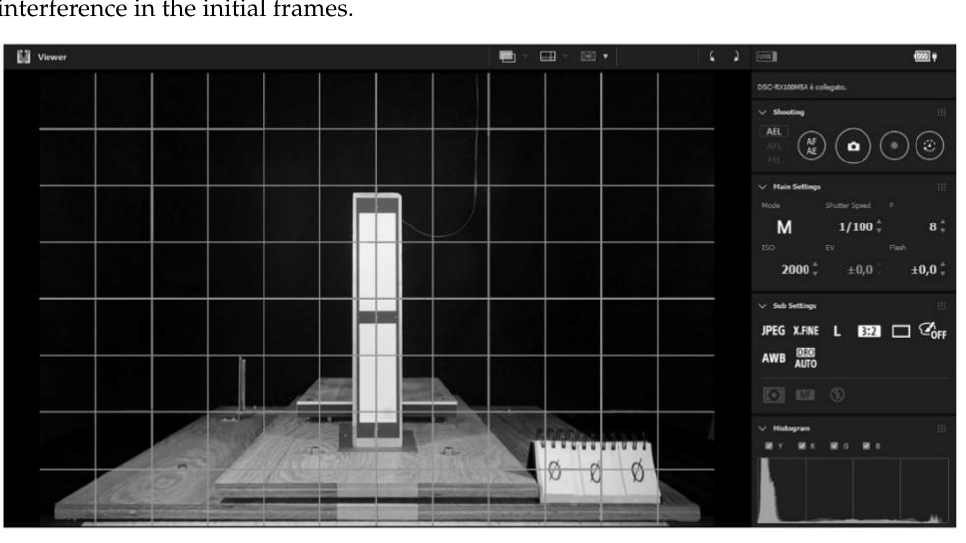
Figure 5. Remote camera control.